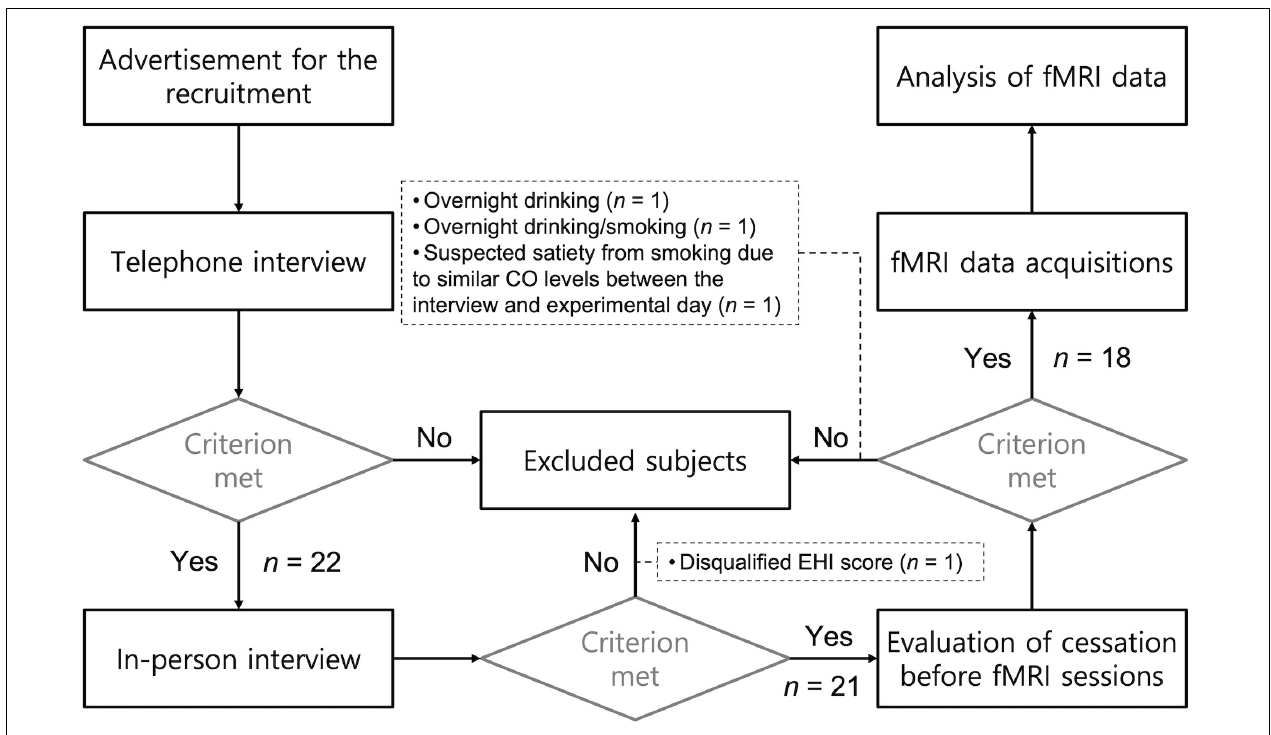
FIGURE 1 | Chematic flowchart for process of subjects